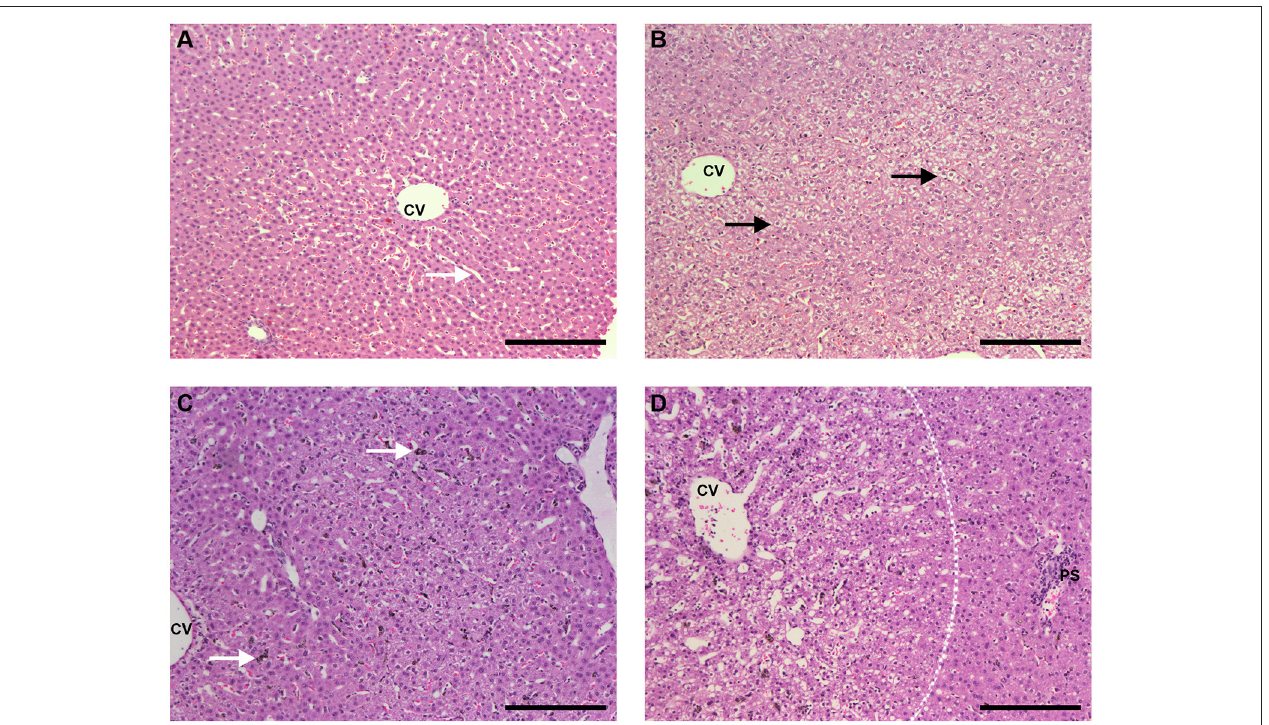
FIGURE 8 | Liver sections HE staining (bar: 200 µ m). (A) Liver of an uninfected, control animal that received PBS (code PA67), showing typical architecture, healthy hepatocytes and clean synusoids (arrows); CV, centrilobular vein. (B) Liver of an uninfected Saimiri inoculated with CL 1 mL (code PB75). The general aspect of most sections was rather normal (similar to the pattern of A ), but eventually areas of hepatocyte vacuolization, as depicted, were observed; CV, centrilobular vein. (C) Liver of a P. falciparum -infected Saimiri that received PBS (code 141: treated at day 17, with 0.69 % parasitemia, killed 5 days later). Kupffer cells laden with hemozoin (arrow); CV, centrilobular vein. (D) Liver of a P. falciparum -infected Saimiri that received CL 1 mL (code 161: treated at day 11, with 22% parasitemia, killed 5 days later). Intense hepatocyte vacuolization was observed, evidenced particularly in the left half of the image, closer to the centrilobular vein (CV) and away from the portal space (PS) (more vacuolized area and more preserved area separated by a dashed